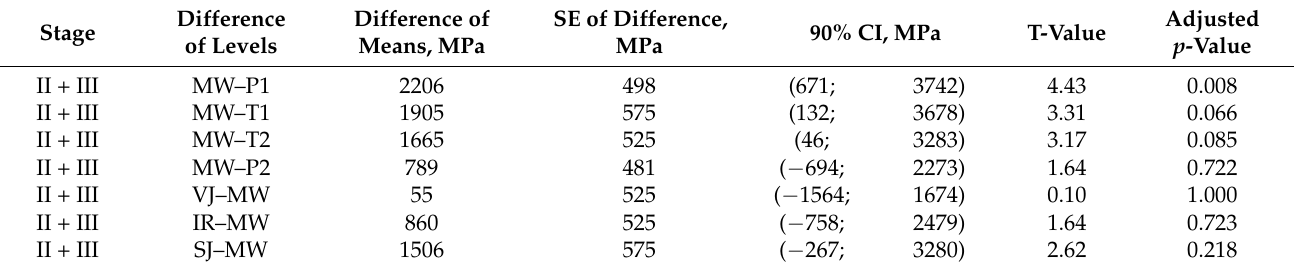
Figure 9. Indirect tension modulus of specimens taken from longitudinal joints. Table 10. Tukey’s pairwise comparison for ITS test strength.